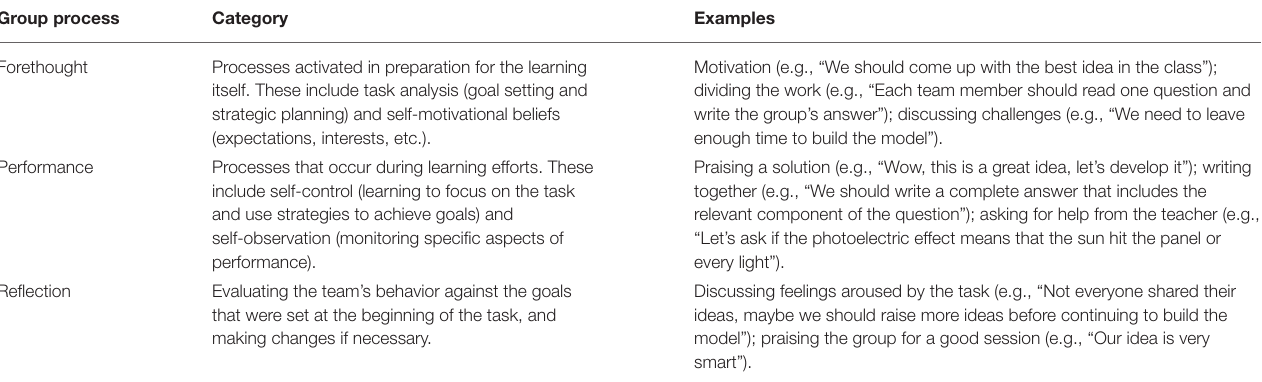
TABLE 2 | Example of data coding. Group process